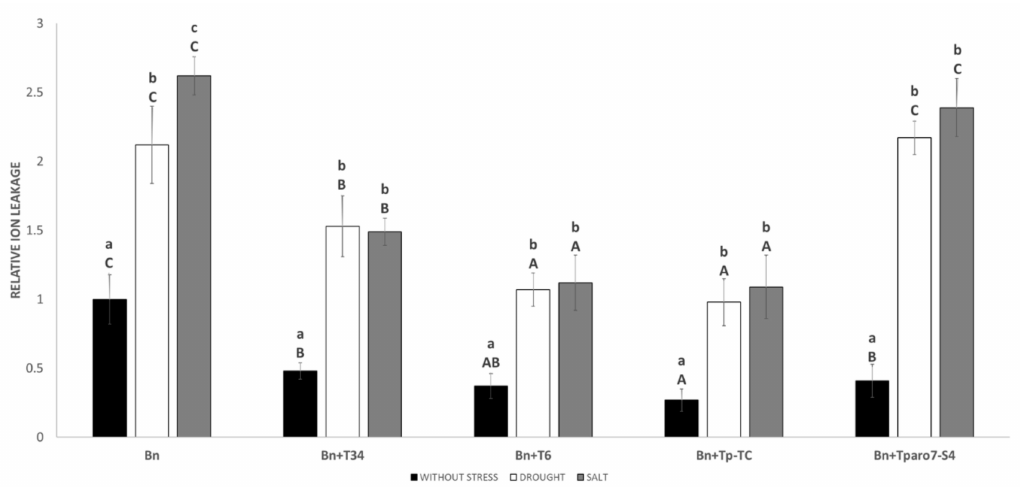
Figure 4. Indirect quantification of ROS in roots by relative ion leakage in the roots of rapeseed (Bn) inoculated with T. harzianum ( + T34), T. parareesei ( + T6), T. parareesei transformation control ( + Tp-TC), and the transformants with the silenced Tparo7 gene ( + Tparo7-S4). Data are the mean of three biological replicates for each condition with the corresponding standard deviation, and for each biological replicate and condition, roots from five plants were used. One-way analysis of variance (ANOVA) was performed, followed by the Tukey’s test. Di ff erent letters represent significant di ff erences ( p < 0.05), comparing between environment within each treatment (strain)- and control-(identify by small letters) and treatment- and control-(strain) within each specific environment (identify by capital letters). Also, two-way analysis of variance (ANOVA) was performed, shown in Supplementary Table